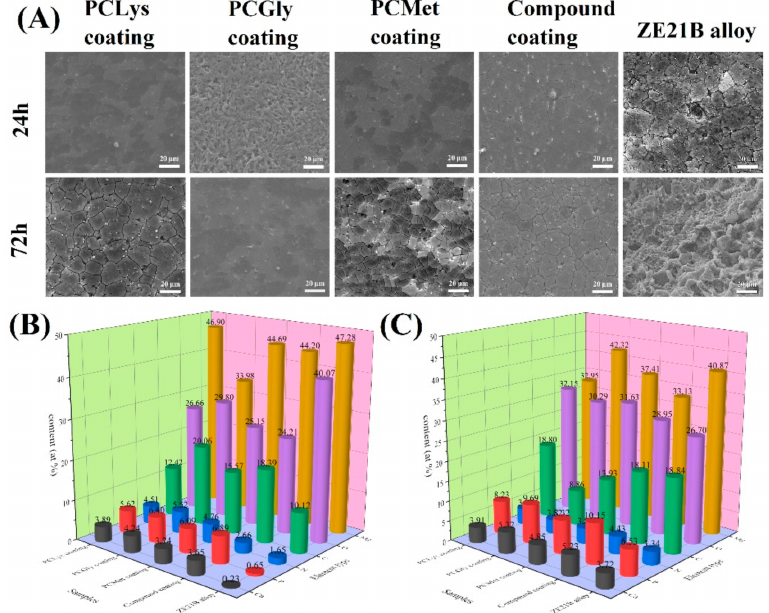
Figure 4. ( A ) SEM images of each sample with corrosion products after being immersed in the RPMI 1640 cell culture medium for 24 h and 72 h; EDS results of each sample with corrosion products after immersed in the RPMI 1640 cell culture medium for ( B ) 24 h and ( C ) 72